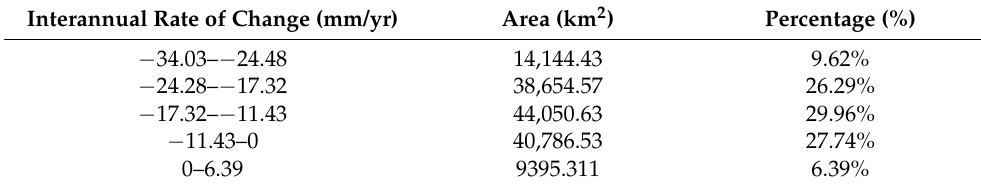
Table 3. Percentage of annual average change in PET in Akmola